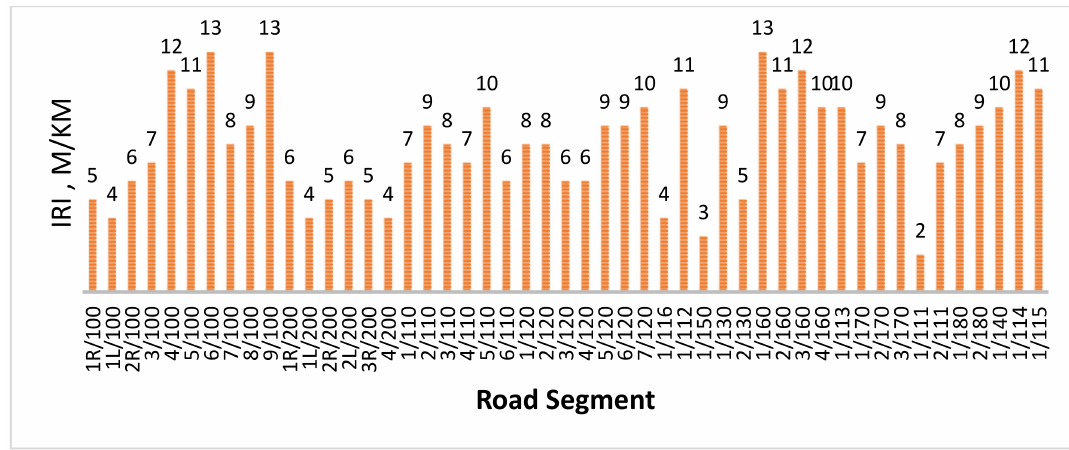
Figure 7. The IRI values of each road